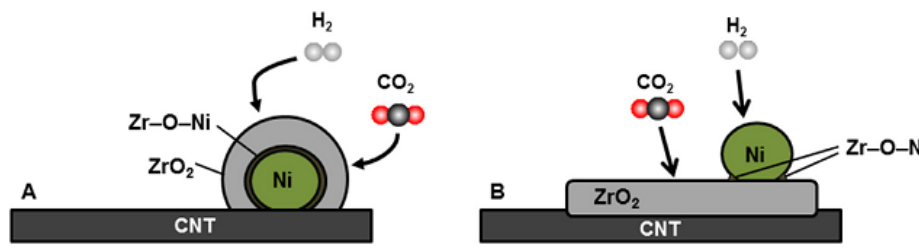
Figure 8. Schematic representation of the disposition of NiO, ZrO 2 and interface Ni-O-Zr at the surface of CNTs for ( A ) Ni-Zr-CNT-COI catalytic system, and ( B ) Ni-Zr-CNT-SEQ catalytic system, reproduced with permission from [36]. Copyright Elsevier, 2018.